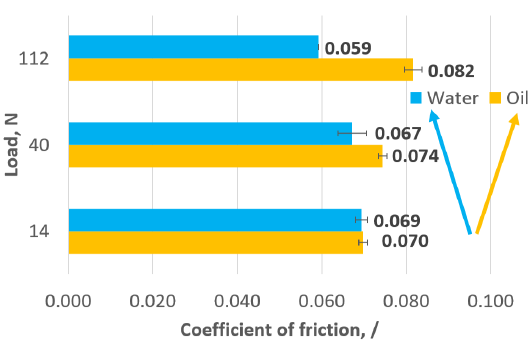
Figure 9. Coefficient of friction of SS/Diamond-Like Carbon (DLC) in oil and water.